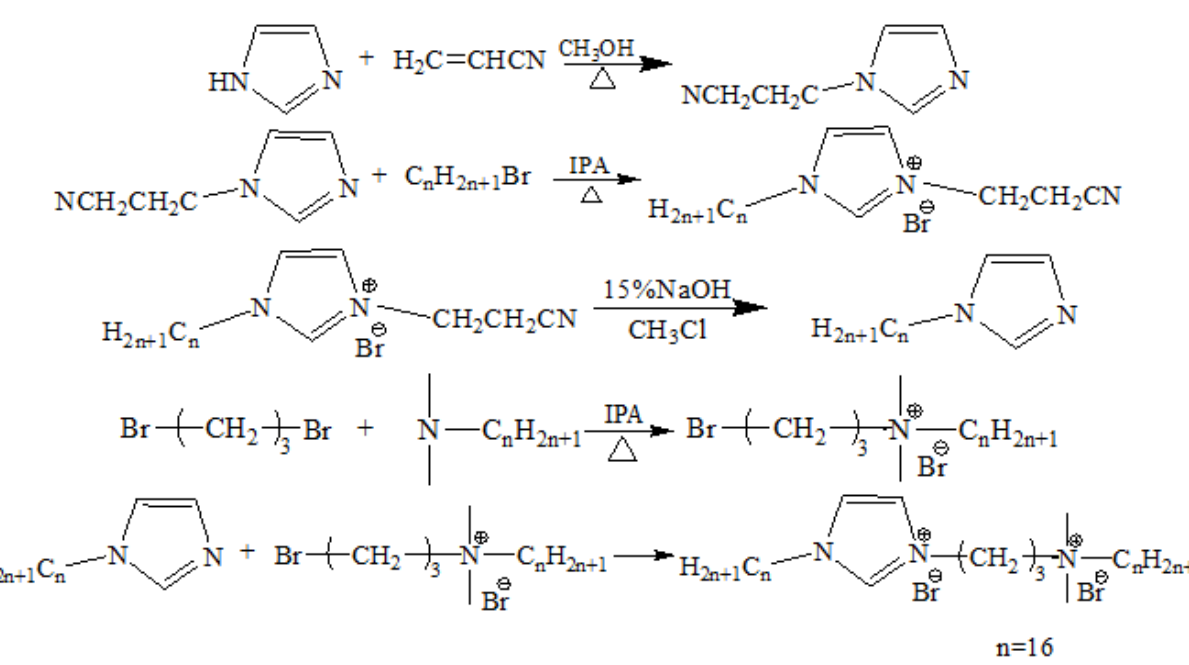
Figure 1. Schematic diagram of the synthesis steps of [N 1116 C 3 IMC 16 ][Br] 2 .